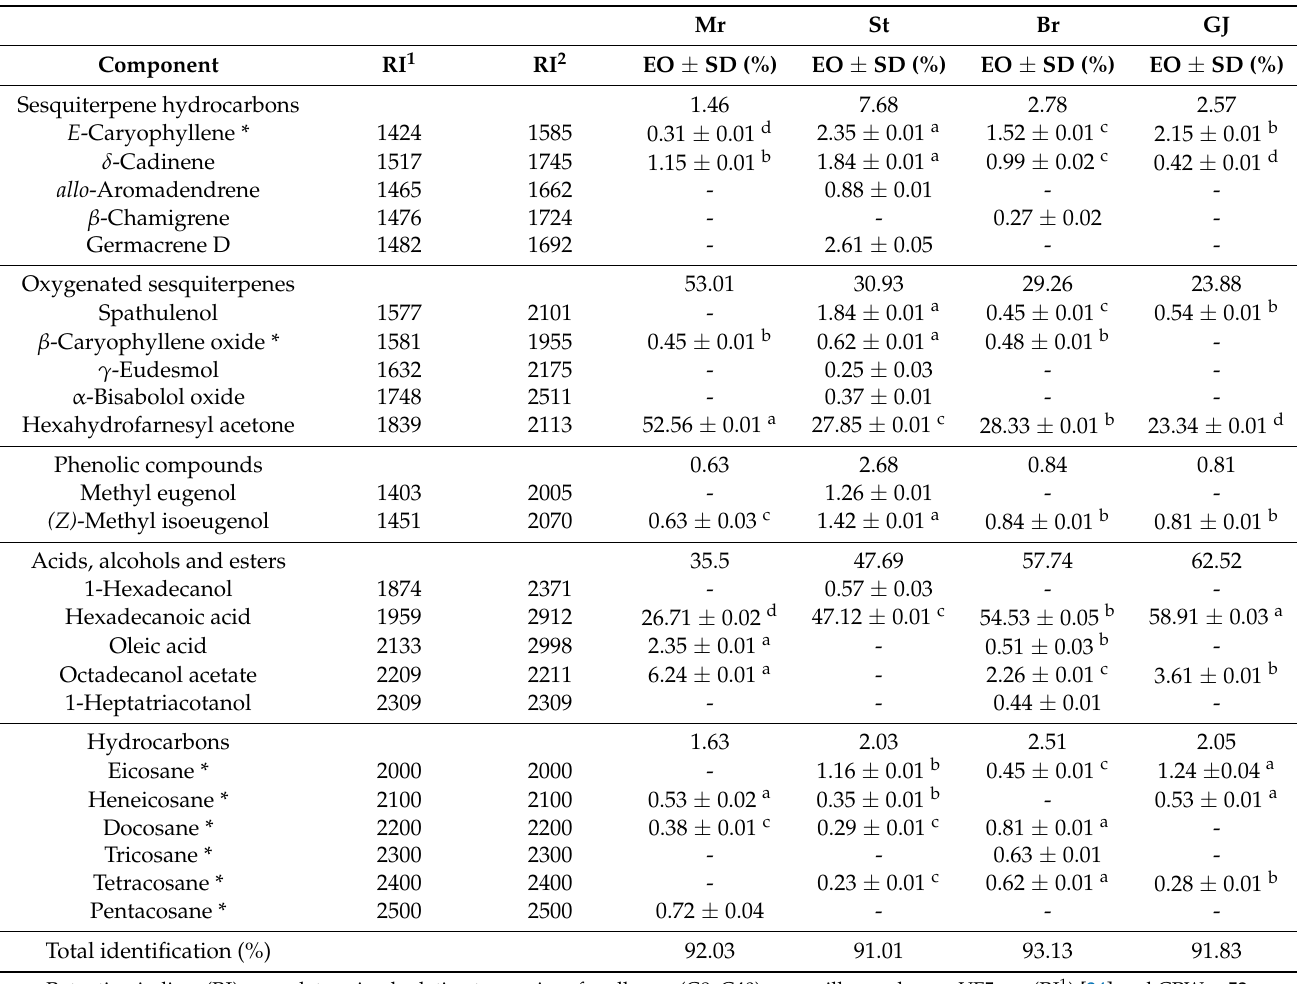
Table 1. Chemical composition of the essential oil from four locations from aerial parts of Veronica austriaca ssp. jacquinii .